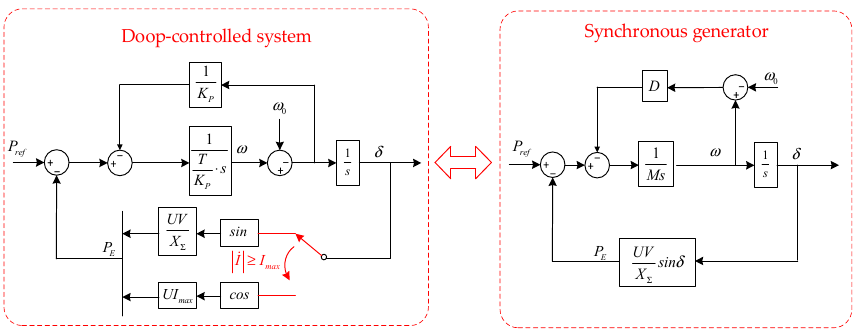
Figure 3. Comparison of the analysis models for synchronizing dynamics analysis in droop-controlled system and the synchronous generator.